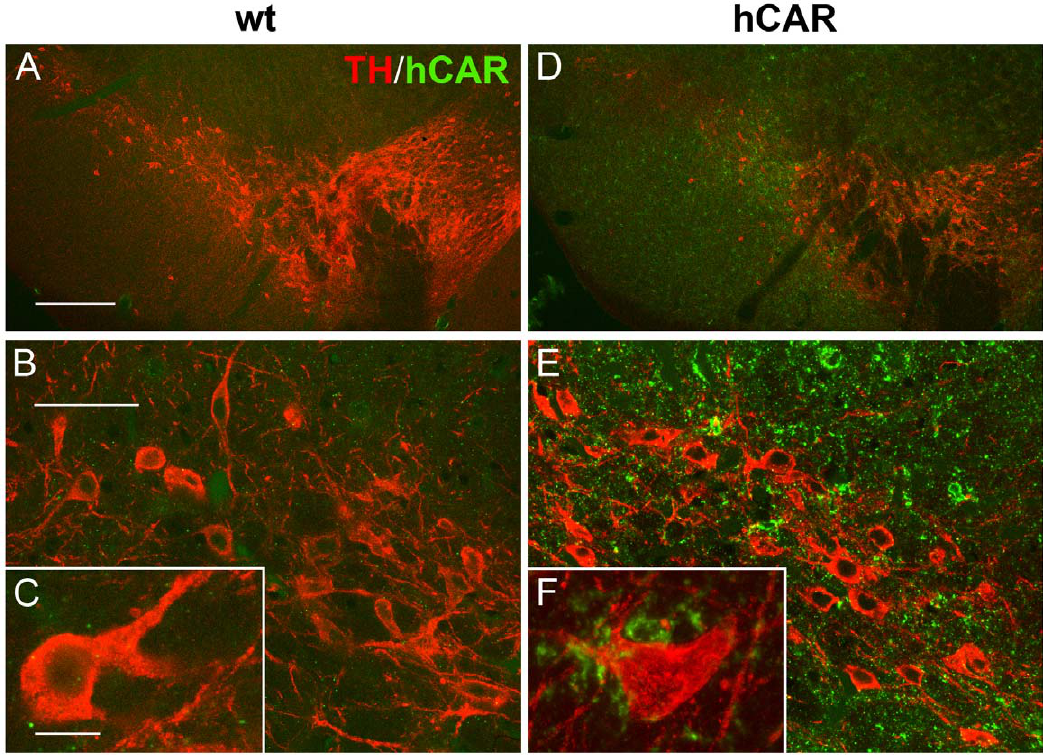
Figure 6. Histological analysis of hCAR localization shows expression in close apposition to SN neurons. Although we were unable to visualize mCAR by immunohistochemistry (data not shown), confocal analysis of hCAR in the substantia nigra of transgenic animals (right panels) showed robust expression throughout the ventral midbrain ( D ). hCAR was readily seen within the SNc ( D, E ), and in close apposition to DA-positive SN neurons ( F ). ( A – C ) Left panels show lack of cross-reactivity of antibody RmcB for mCAR. Scale bar A , D : 250 m m, B , E : 50 m m, C , F : 10 m m. Red = TH-positive neurons, Green = hCAR.